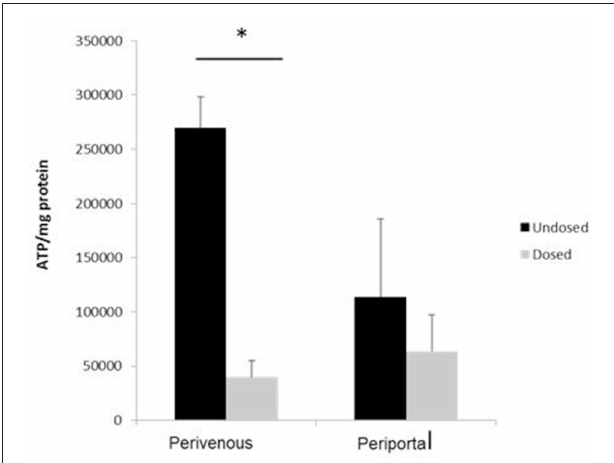
FIGURE 6 | Confirmation of zone specific metabolism. Cells were dosed with 50mM paracetamol for 48h. Viability (calculated using ATP assay) was normalized to protein concentration calculated using a Bradford assay. n = 3, student’s test used for statistical analysis. * p <